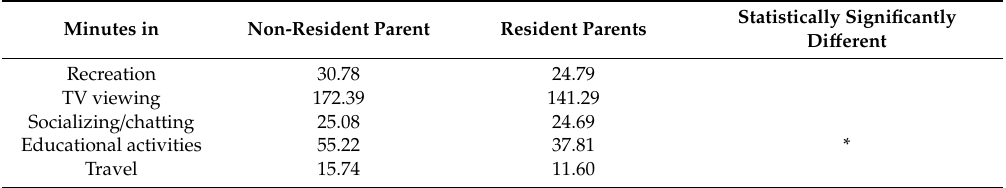
Table 3. Minutes Spent with Siblings across Different Activities by Parental Residency ( n = 1558 Adolescents). Minutes in Non-Resident Parent Resident Parents